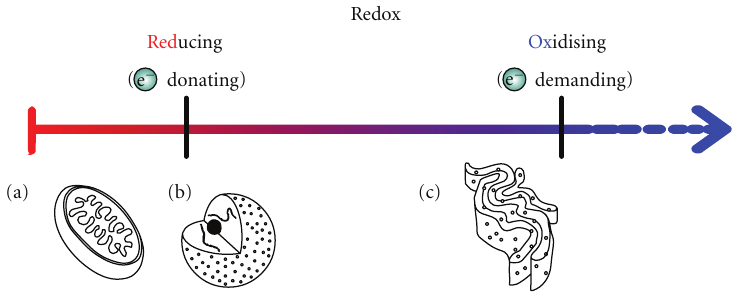
Figure 3: Redox state of between di ff erent cellular compartments. Redox state is a measure of the amount of electrons available for redox reactions. In the reducing state electrons are donated, whereas in the oxidising state electrons are removed. The mitochondria and nucleus are reducing (a and b). The endoplasmic reticulum is more oxidising